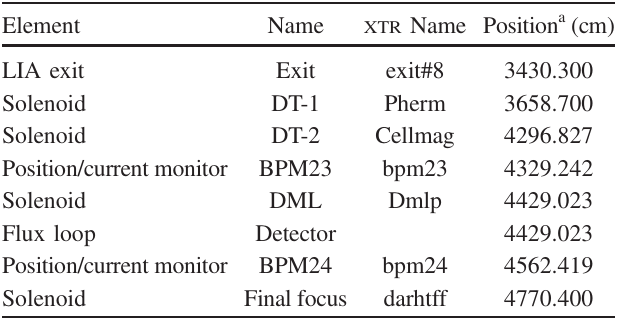
TABLE II. Location of DST elements. Element